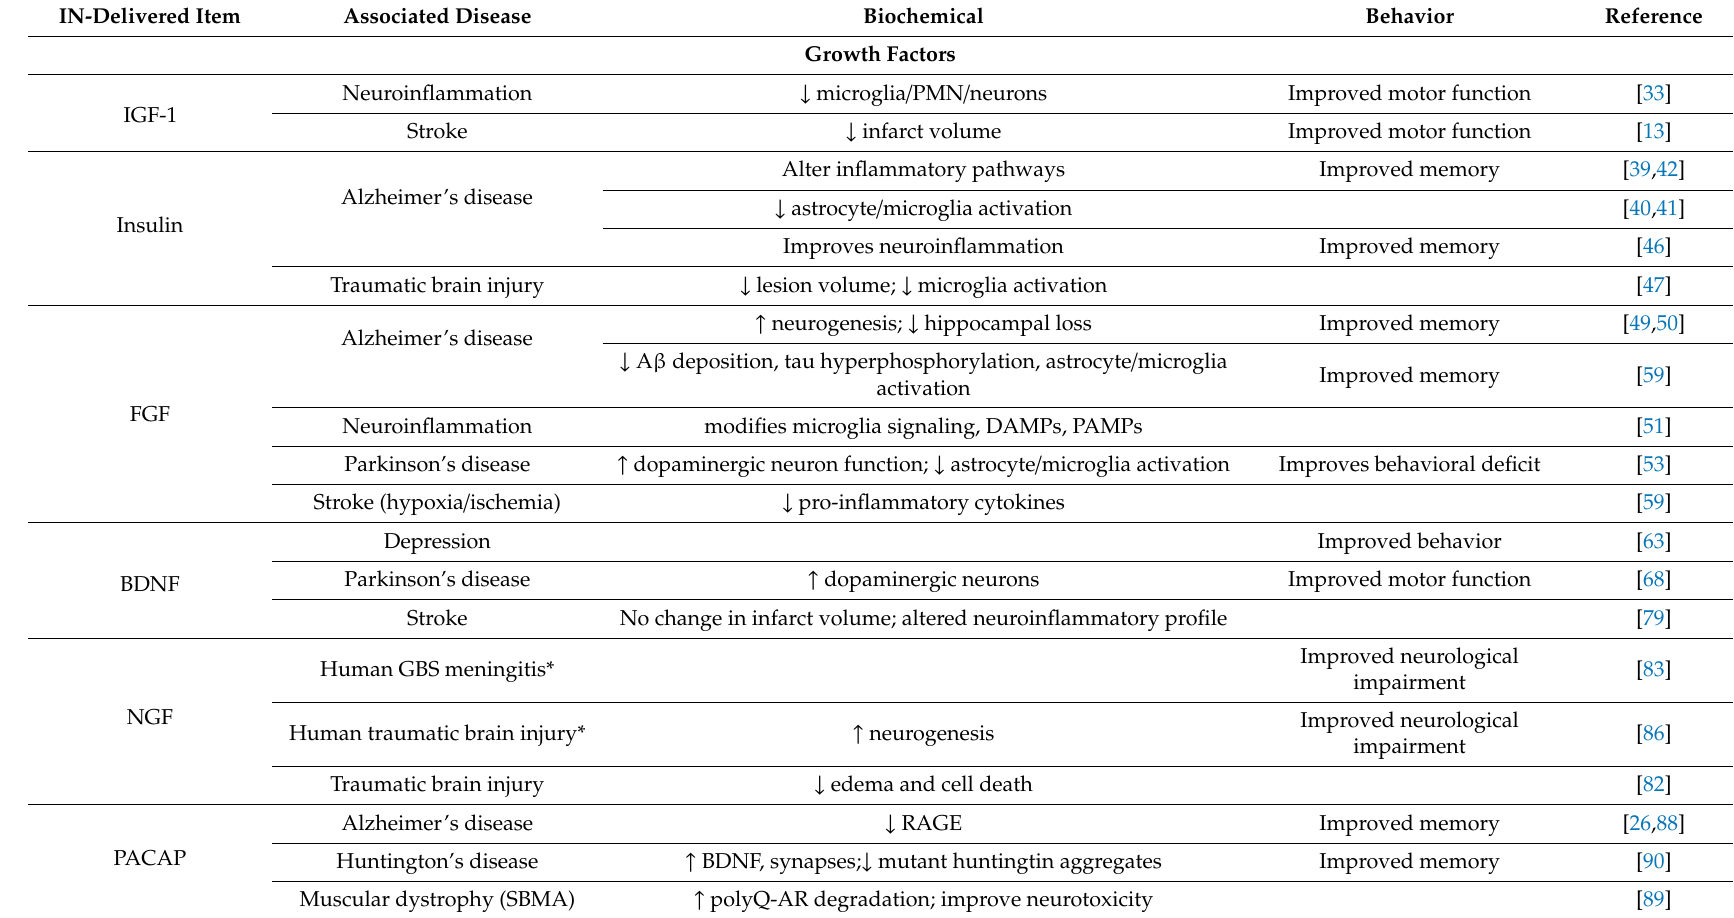
Table A1. Summary of outcome following intranasal